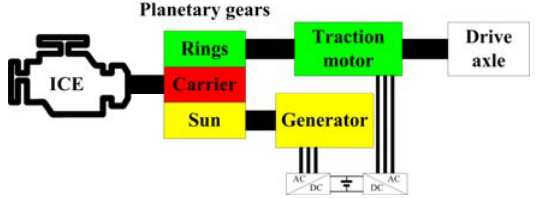
Figure 19. Schematic of the Toyota hybrid system